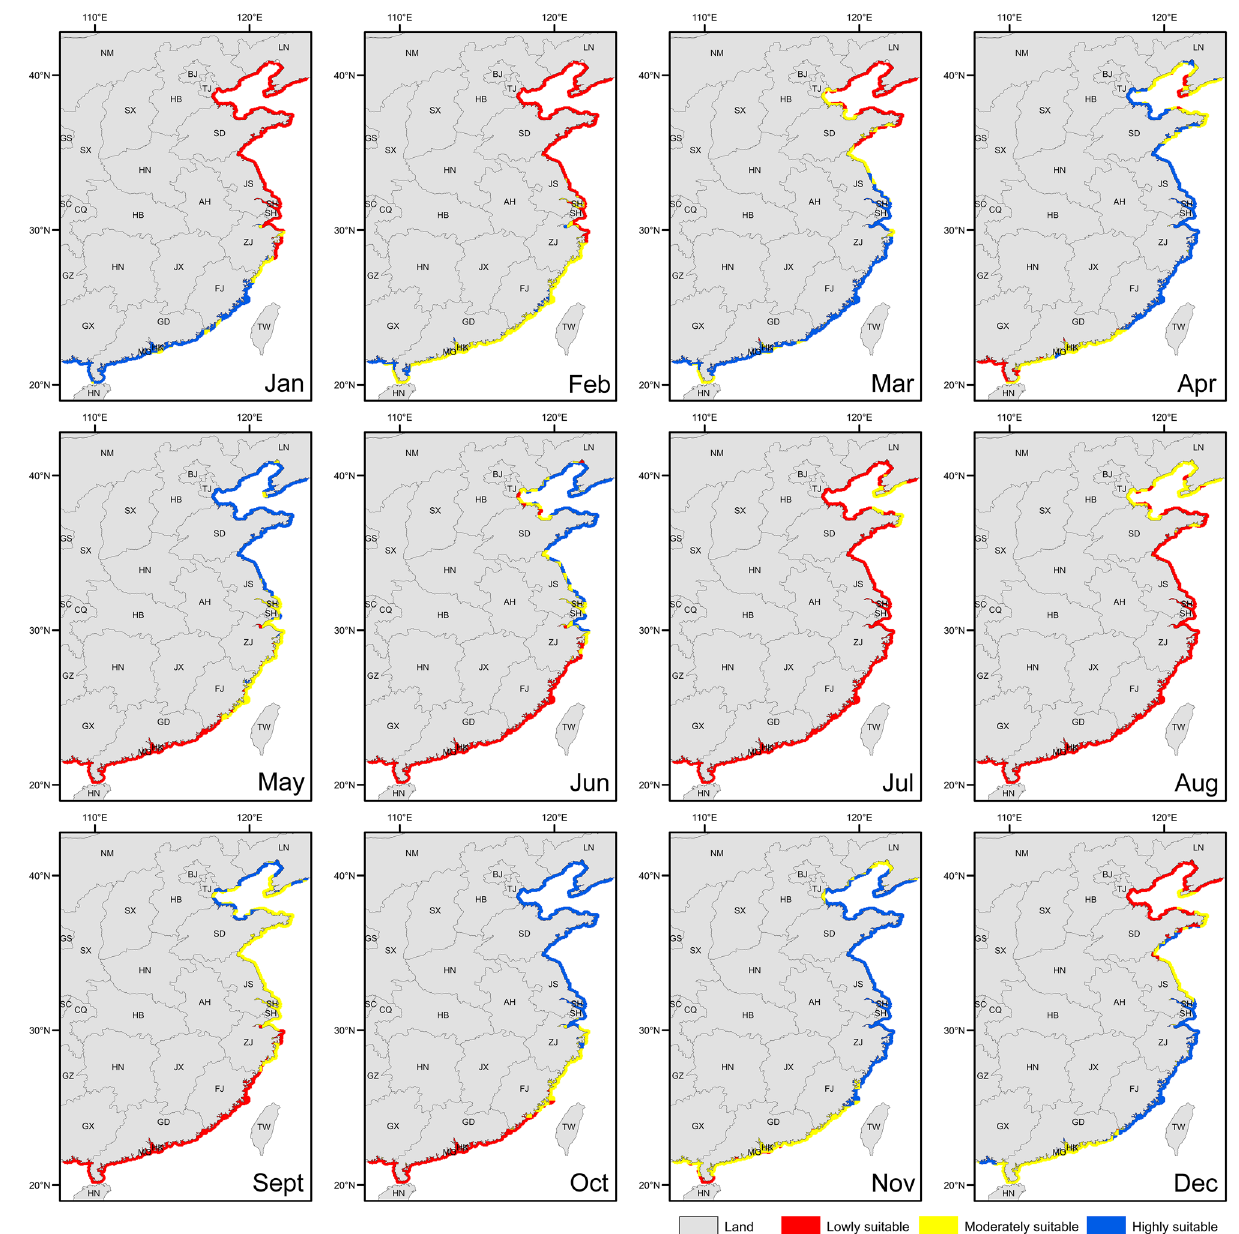
Figure 2. Site suitability for Apostichopus japonicus aquaculture in China. The blue represents the areas that are highly suitable for A. japonicus aquaculture. The yellow indicates that the suitability index of sea areas is medium. The red indicates that the suitability index is